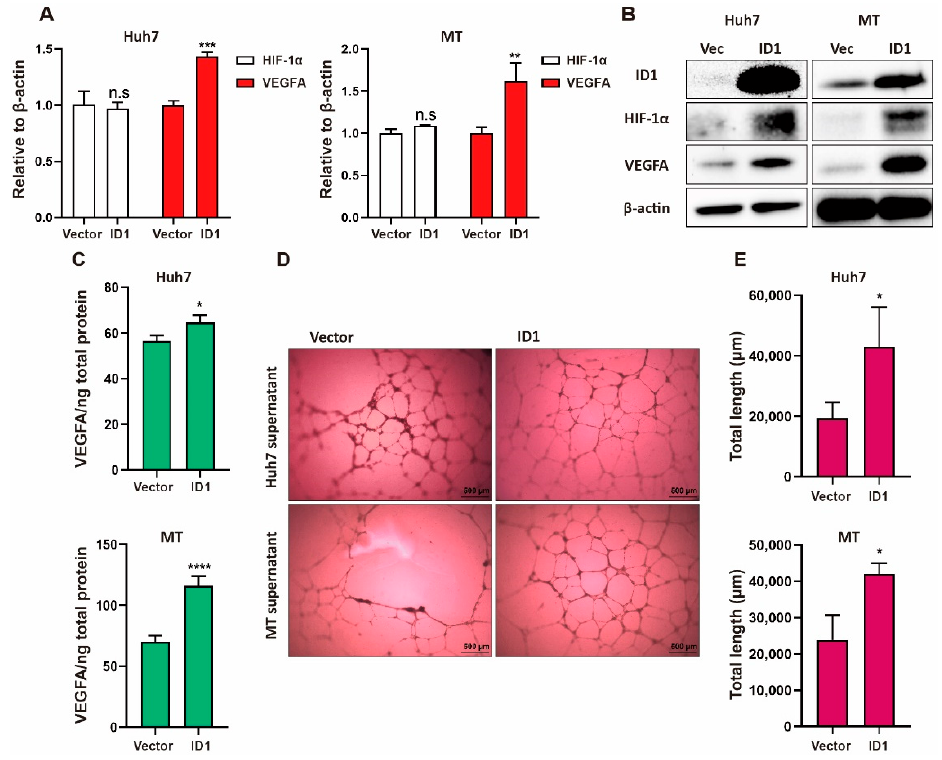
Figure 5. Overexpression of ID1 promotes HIF-1 α /VEGFA signaling activity in HCC cells. ( A ) Rel- ative gene expression levels of HIF-1 α and VEGFA in Huh7 and MT cells. Cells were harvested following transfection with 1 μ g vector or ID1 plasmid for 48 h. ( B ) Western blot analysis of ID1, HIF-1 α and VEGFA in Huh7 and MT cells. Cells were harvested following transfection with 1 μ g